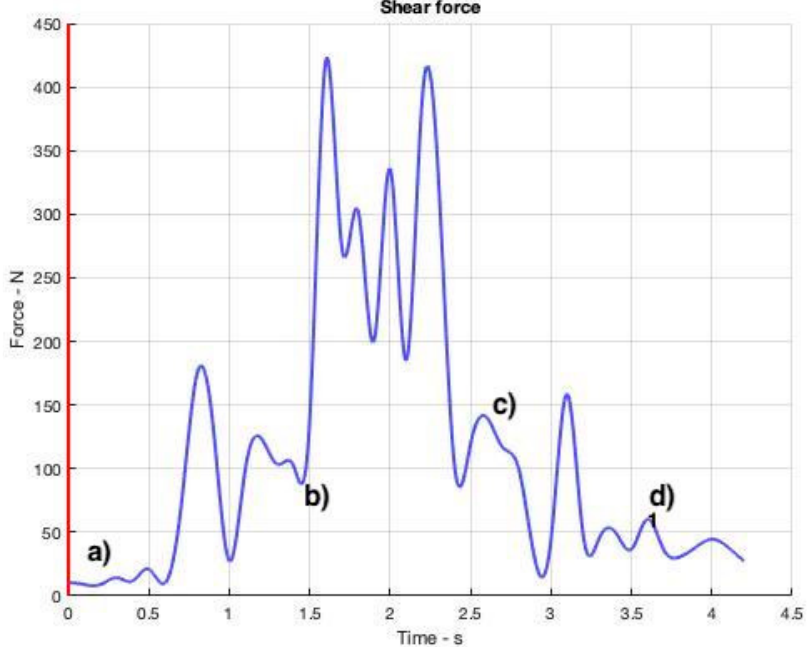
Figure 10. Sheer force values at the L5-Pelvis joint throughout the OTP. The instants corresponding to the four snapshots in Figure 6 are indicated from ( a – d ).